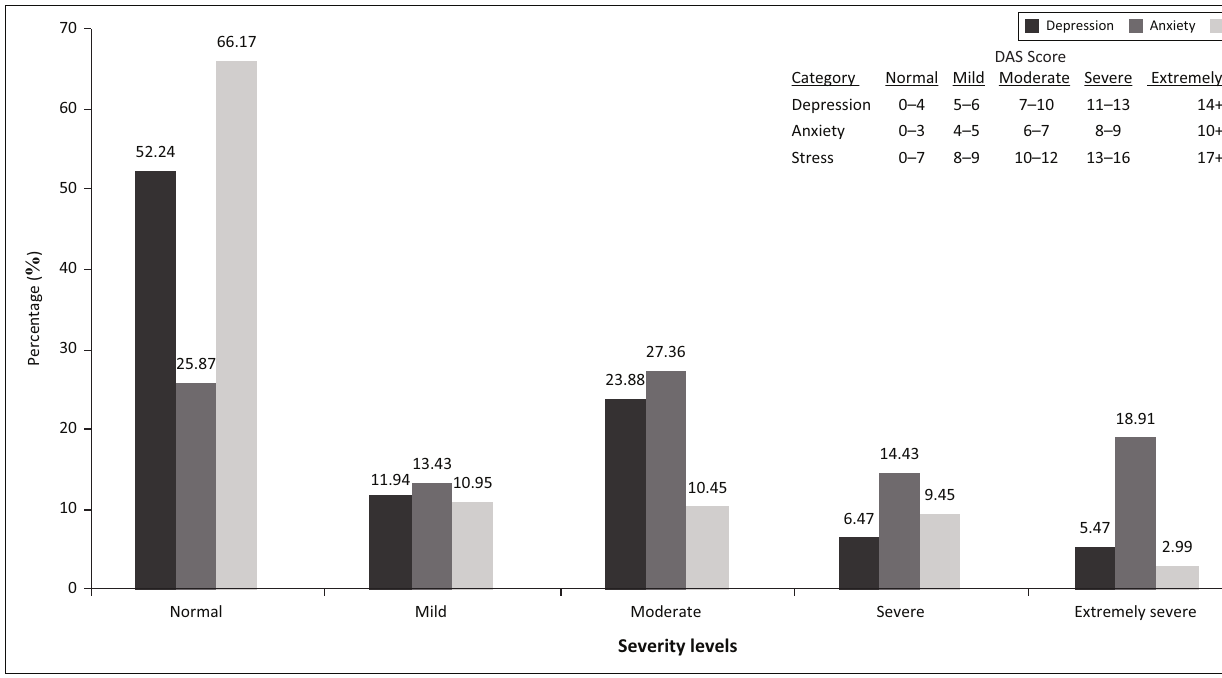
FIGURE 1: Frequency of symptoms and severity for depression, anxiety and